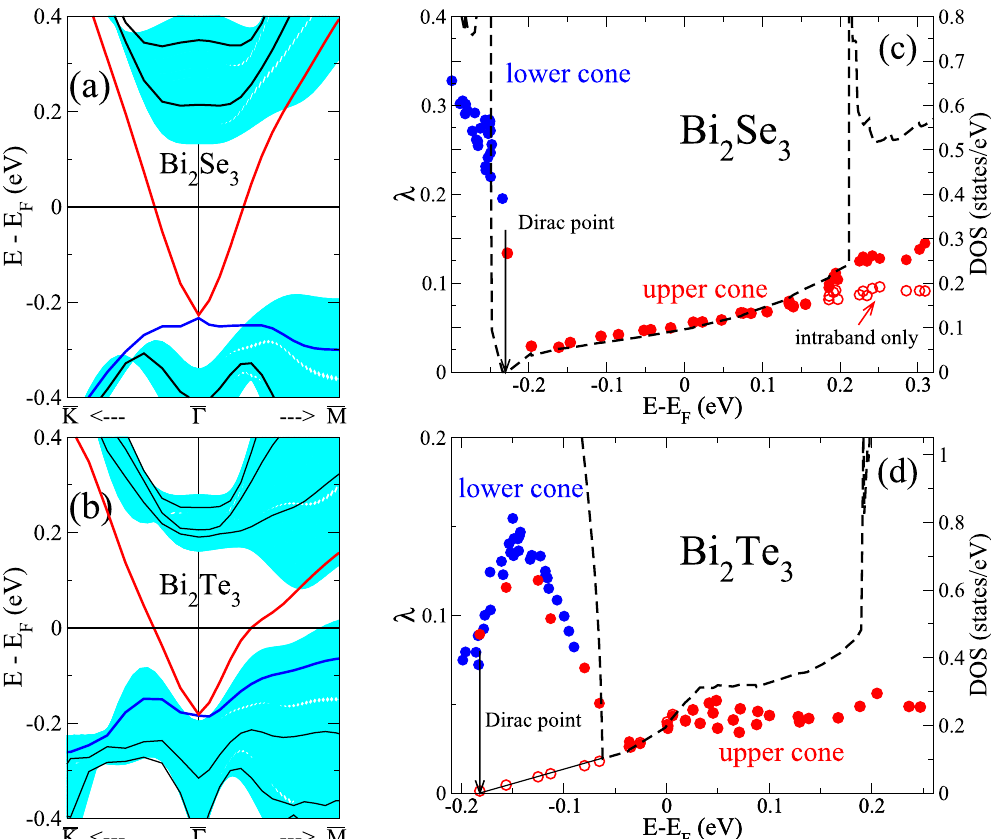
Figure 1. ( a , b ) Electronic dispersion of 3 QL Bi 2 Se 3 ( a ) and 4QL Bi 2 Te 3 ( b ), respectively. The energy region of surface-projected bulk states is indicated by the shaded area. ( c , d ) State-dependent electron-phonon coupling constants for Bi 2 Se 3 ( c ) and Bi 2 Te 3 ( d ). λ for both upper (red) and lower (blue) part of the Dirac cone is plotted over the energy of the corresponding electronic state. Open (red) circles denote the intraband contribution for the upper part of the cone, i.e. without coupling to the first bulk-like conduction band. The dashed line indicates the density of states